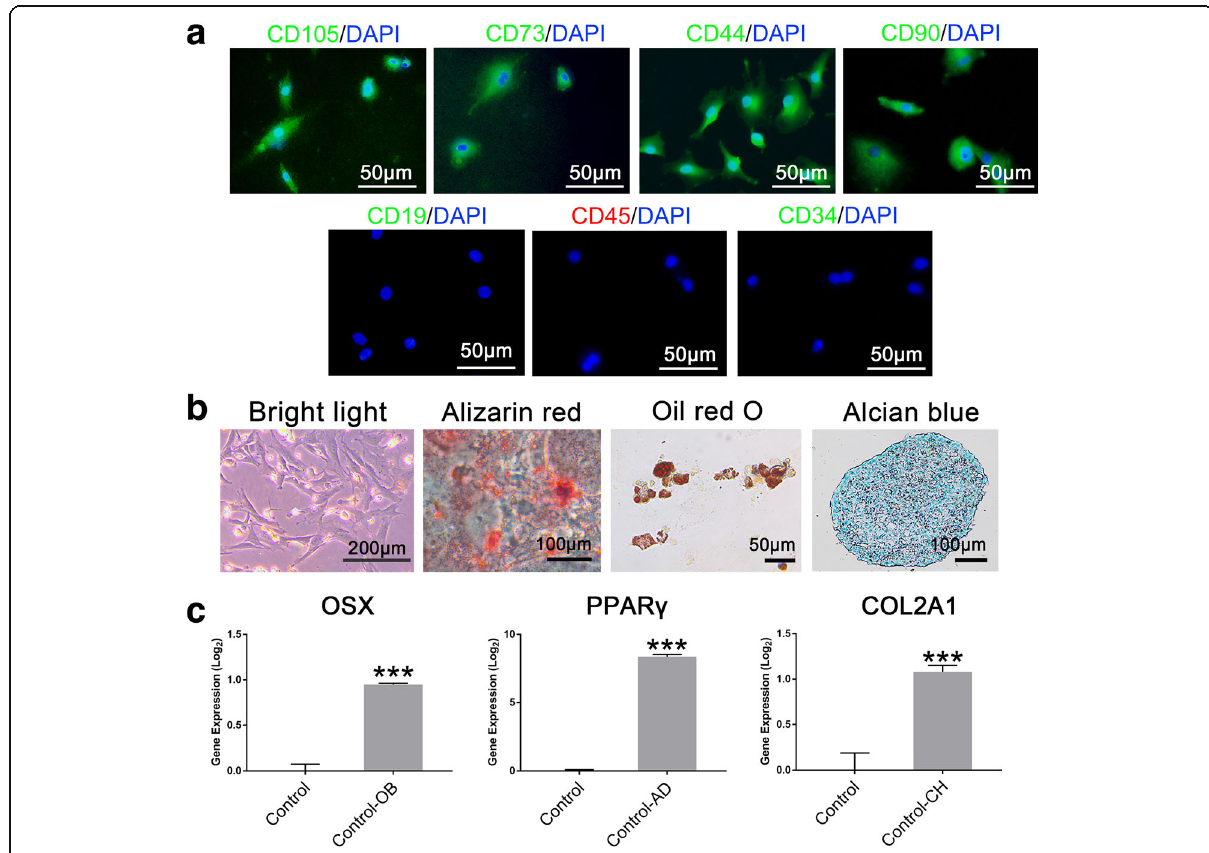
Fig. 1 Identification of rat bone marrow mesenchymal stem cells. a Dual-staining of rat bone marrow mesenchymal stem cells (rbMSCs) with CD44/DAPI, CD19/DAPI, CD45/DAPI, CD105/DAPI, CD73/DAPI, CD34/DAPI and CD90/DAPI. b Cell morphology before induction in bright light. Three-lineage differentiation of rat mesenchymal stem cells. Osteogenic differentiation is determined by Alizarin red staining, adipogenic differentiation is determined by Oil Red O staining, and chondrogenic differentiation is identified by Alcian blue staining. c qRT-PCR analysis of OSX levels upon osteogenic differentiation,, PPAR γ upon adipose differentiation and COL2A1 levels upon chondrogenic differentiation. *** p < 0.001, n = 3, when samples were compared to Control